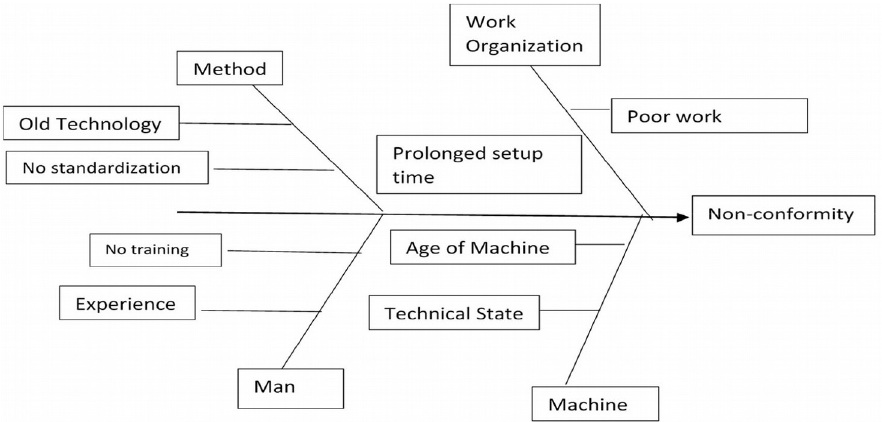
Figure 7. Root Causes and Effects Diagram of the Problems in AB production